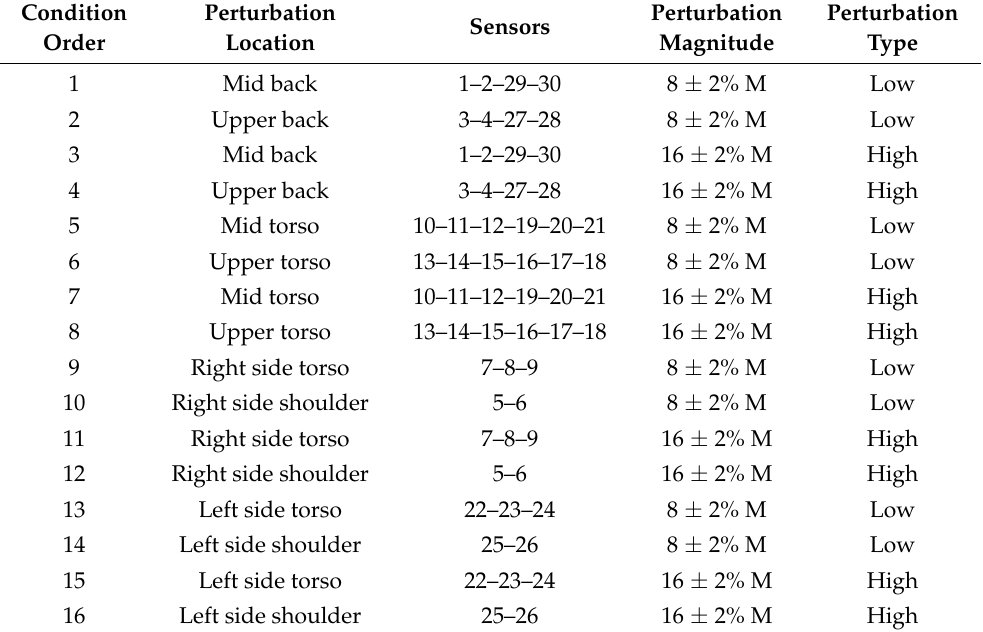
Figure 5. Example of mean and SD of five suitable perturbations provided for Low (green) and High (blue) magnitudes. The perturbation duration is defined as the interval in which the force is exceeding the detection threshold, which is set to 5 N (dashed line). Table 1. Location and type of the perturbations within the pre-defined protocol. The selection of sensors is based on the zones defined in Figure 3. M stands for the total mass of the participant (+ exoskeleton if present). Five good repetitions of the same condition are required to be recorded by the user